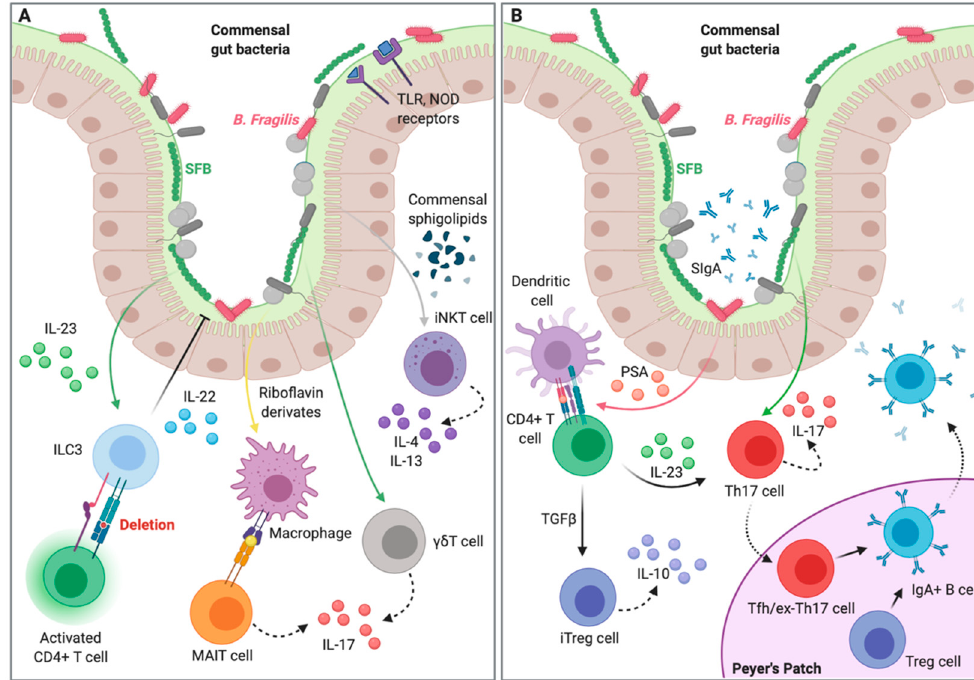
Figure 1. Key host – microbiota interactions in homeostasis. ( A ) Microbiome-derived metabolites and TLR/NOD ligands can be picked up directly by epithelial cells and immune cells. Riboflavin metabolites are presented by macrophages to MAIT cells, promoting their maturation and cytotoxic activity. Commensal-induced cytokines promote IL-17A production from γδ T cells. ILC3-derived IL-22 prevents bacteria translocation to the lamina propria. Moreover, MHCII-expressing ILC3 deplete commensal-specific CD4+ T cells to prevent immune responses against harmless commensals. Early life colonization limits iNKT expansion within the colonic lamina propria and lungs via commensal sphingolipids. ( B ) Intestinal colonization by segmented filamentous bacteria (SFB) promotes Th17 cell differentiation. SFB colonization drives an ILC3/IL-22/SAA1/2 axis that licenses IL-17A production. Foxp3+ Treg cells and Tfh/ex-Th17 cells localize in the Peyer’s patches and promote B cell class-switch and production of IgA, which are then secreted in the intestinal mucosa. Colonization with Bacteroides fragilis promotes CD4+ T cell differentiation via polysaccharide A (PSA) presentation from dendritic cells. In the presence of TGF β CD4+ T cells can differentiate in induced Treg (iTreg) and produce IL-10 to promote tissue homeostasis. Created with